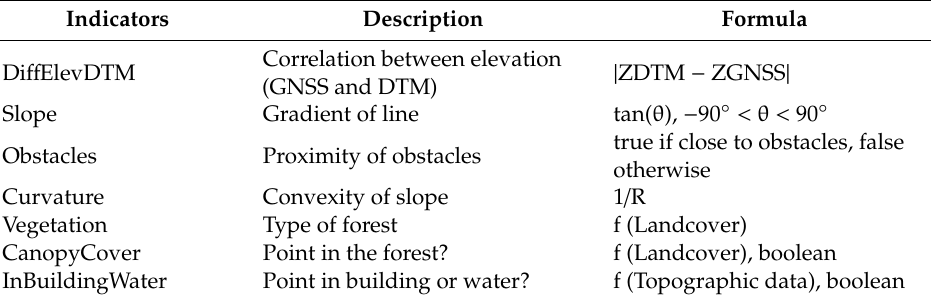
Table 2. Extrinsic